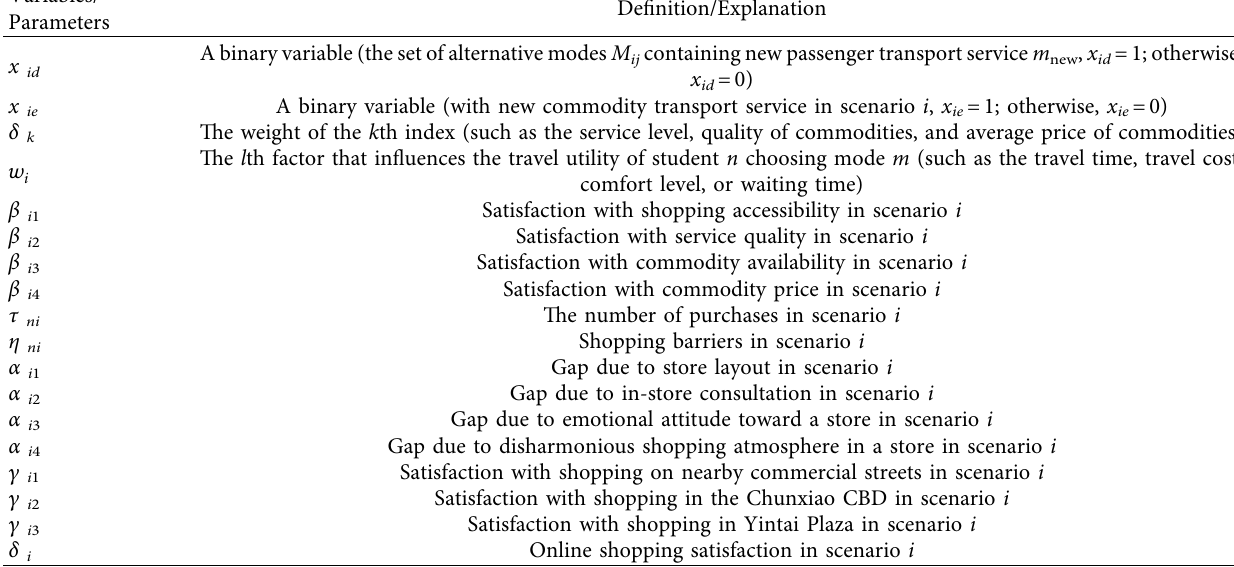
Table 3: Nomenclature of